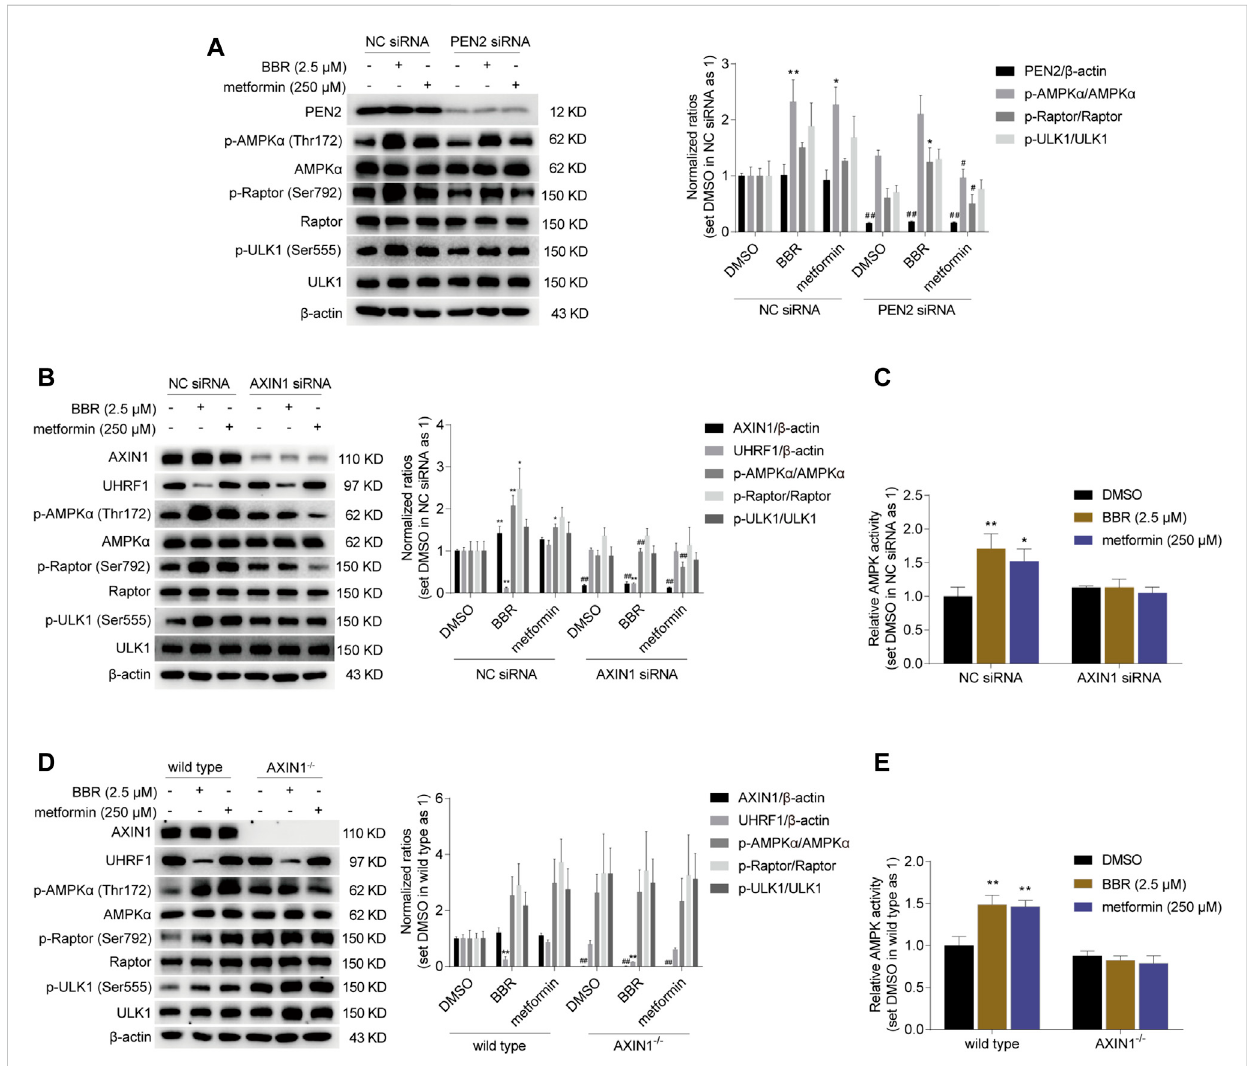
BBR induced AMPK activation was diminished in AXIN1 knockdown and AXIN1 − / − cells. BBR ’ s effect was not in fl uenced on phosphorylation of AMPK α ,RaptorandULK1inPEN2knockdowncells (A) .BBR ’ seffectwasdecreasedonstimulatingAMPKactivityinAXIN1knockdowncells (B,C) .HCT-116 cells were transfected separately with PEN2, AXIN1 and non-sense control (NC) siRNAs. 24 h after transfection, cells were treated with DMSO, BBR (2.5 μ M) and metformin (250 μ M) for 20 h, respectively. BBR ’ s effect was inhibited on promoting AMPK activation in AXIN1 − / − cells (D, E) . AXIN1 was knocked out in HCT-116 cells and the monoclonal transfectants were selected as described in Methods. The wild type and AXIN1 − / − cells were starved overnight and treated with DMSO, BBR (2.5 μ M) and metformin (250 μ M) for 20 h, respectively. The ratio was set as 1 in the NC siRNA transfected (A – C) and wild type (D, E) cells treated with DMSO, respectively. Data are expressed as the mean ± SEM of three separate experiments; * p < 0.05, ** p < 0.01 versus thatofthevehicle(DMSO)treated groupinthesametransfected cells; # p < 0.05, ## p < 0.01 versus that ofthecorrespondingtreated groupin the NC siRNA transfected or wild type